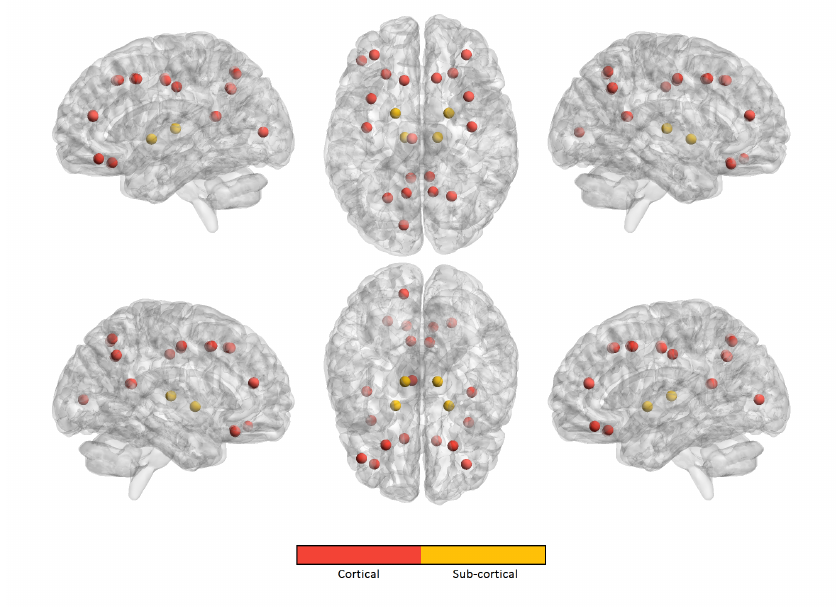
Figure 7. The most significant ROIs for the RF age prediction with no harmonization in ASD